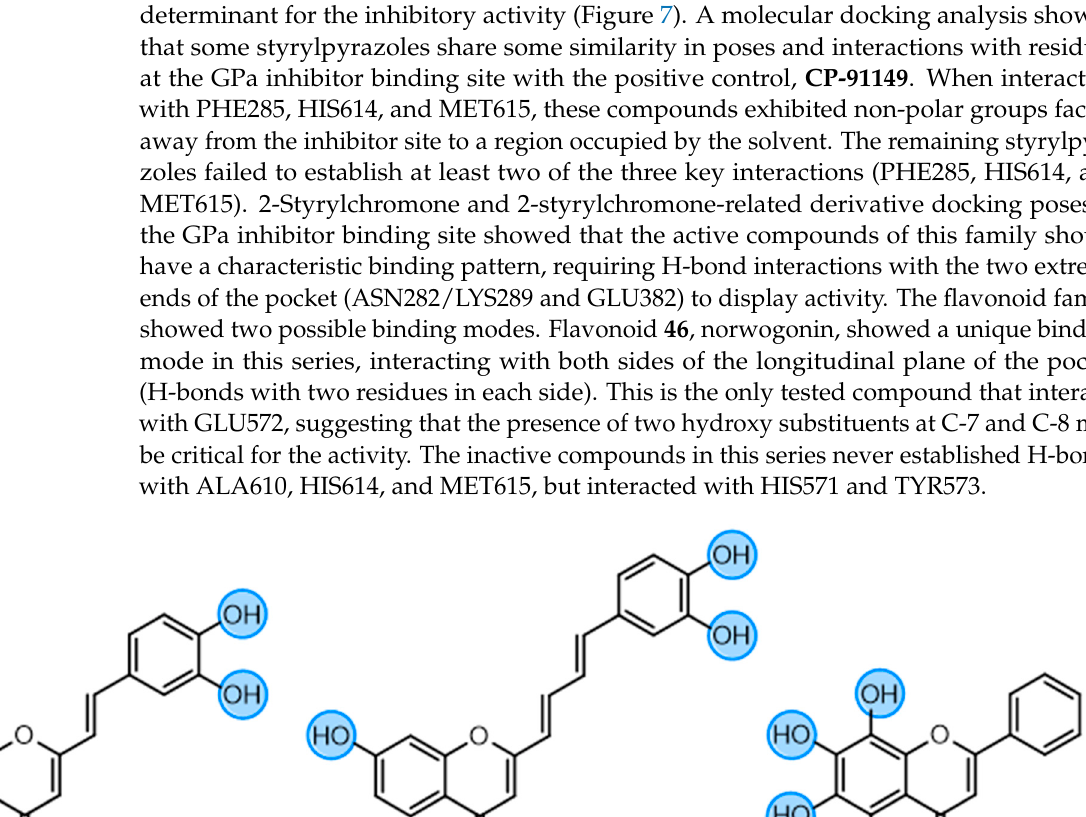
Figure S7: X-ray contacts observed in the PDBs considered in cross-docking; Table S1: PDB structures used in this study; Table S2: Activities, docking scores and ligand efficiency (LE) across all compounds developed in this work.